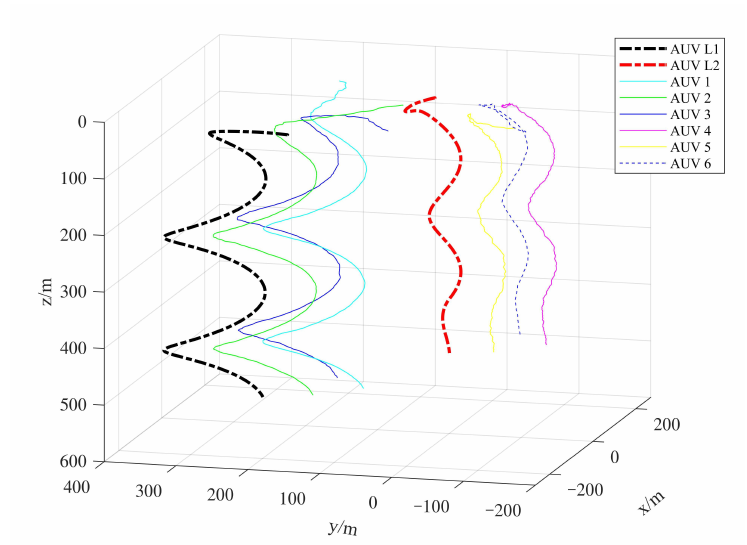
Figure 8. Three-dimensional trajectories of a multiple stochastic AUV